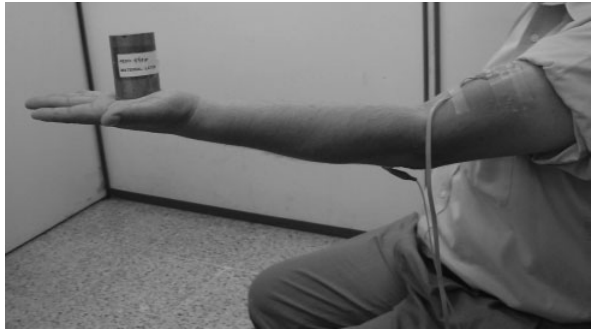
Figure 4 Outline of the arm with the weight, showing the vectors that intervene in the taking of the